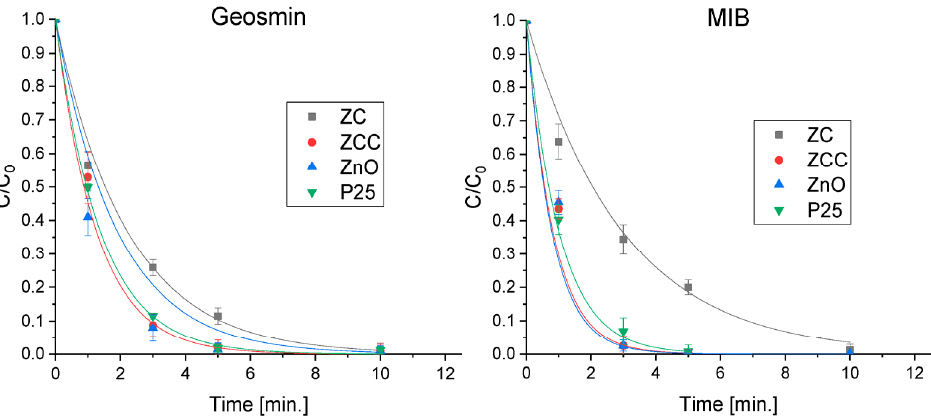
Figure 3. Degradation profiles of geosmin and MIB obtained using synthesized materials and the benchmark P25. benchmark